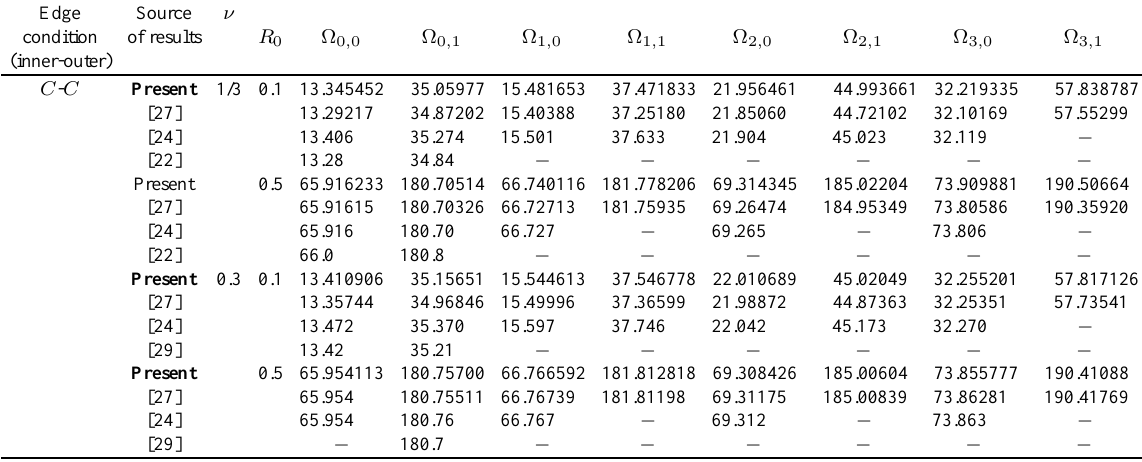
Table 3 Comparison of Ω m,n for isotropic annular plates of linearly varying thickness when α = 1 . 0 , β = 0 . 0 , e r = 1 . 0 ,g r = 0 . 384 ,K f = 0